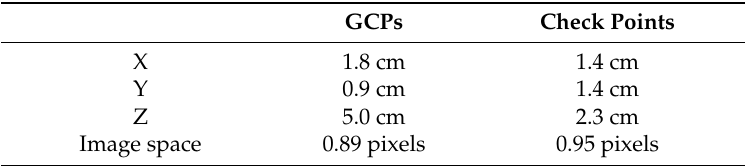
Table 3. Bundle adjustment errors in RMSE.